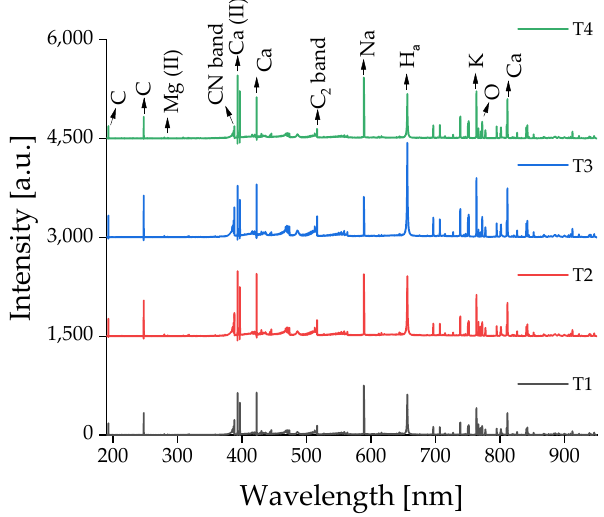
Figure 7. Averaged raw LIBS spectra of cheese samples measured on four different dates using the handheld LIBS system. Note that every measurement was conducted every two weeks.